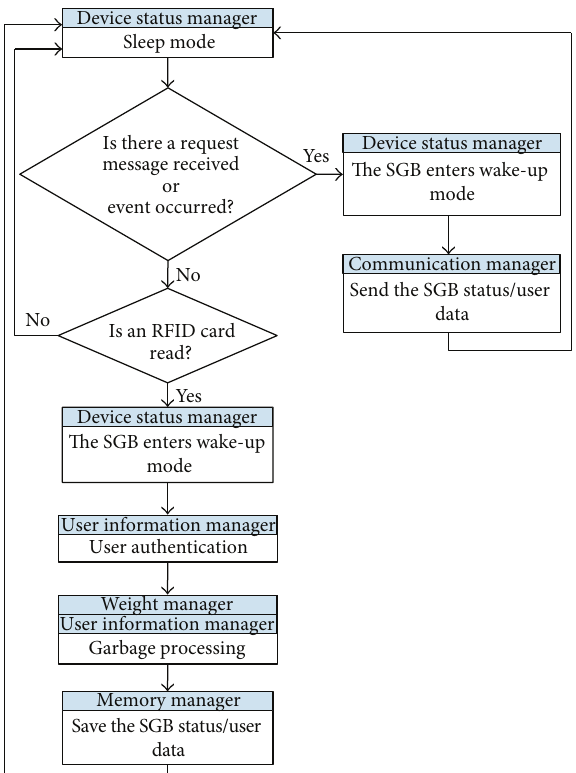
Figure 5: Flowchart of energy-efficient stand-alone operation of a smart garbage